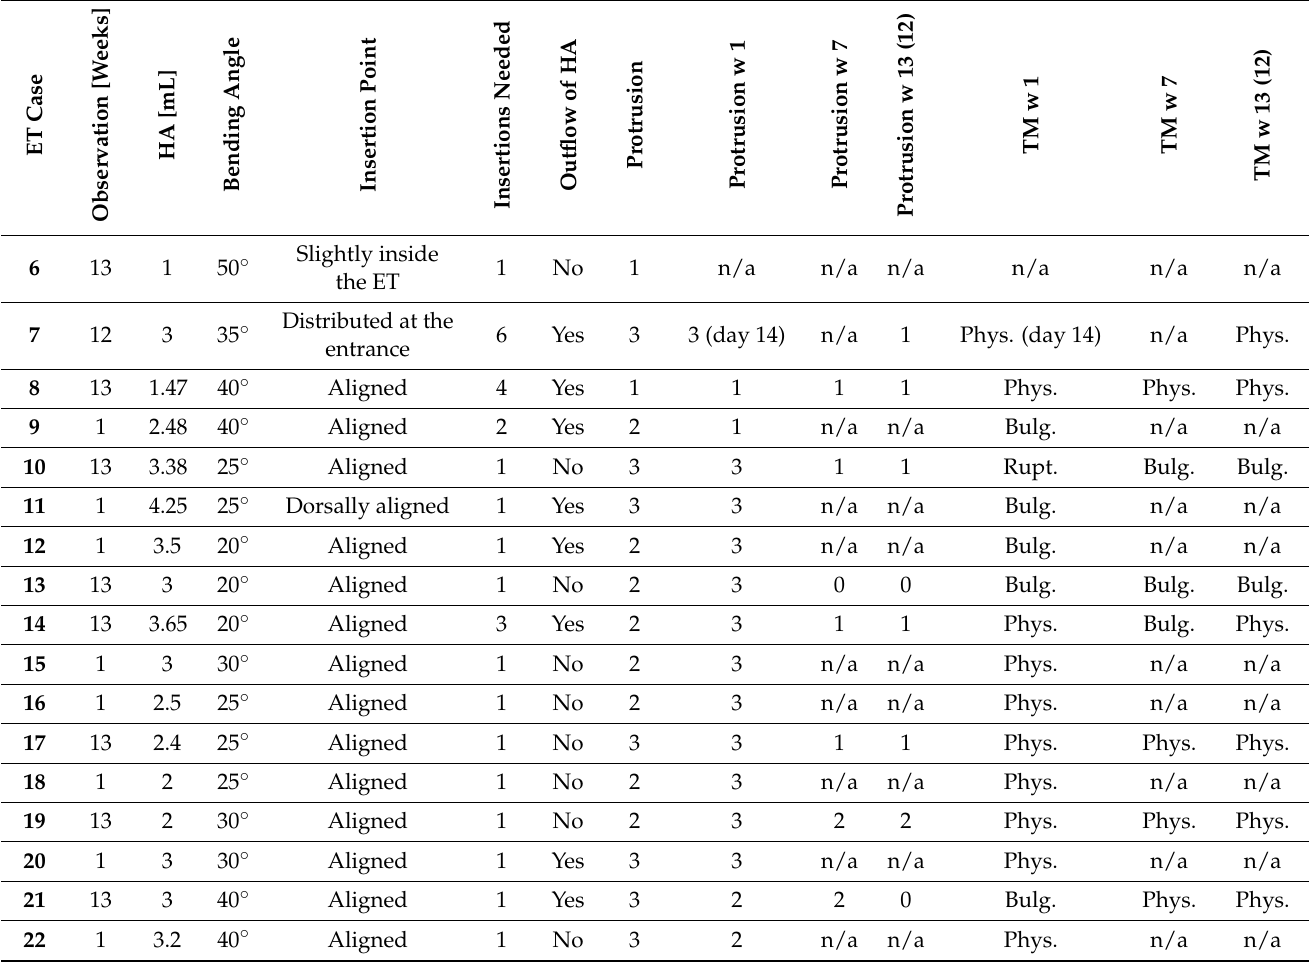
Table 4. In vivo cases injected with stabilized HA in chronological